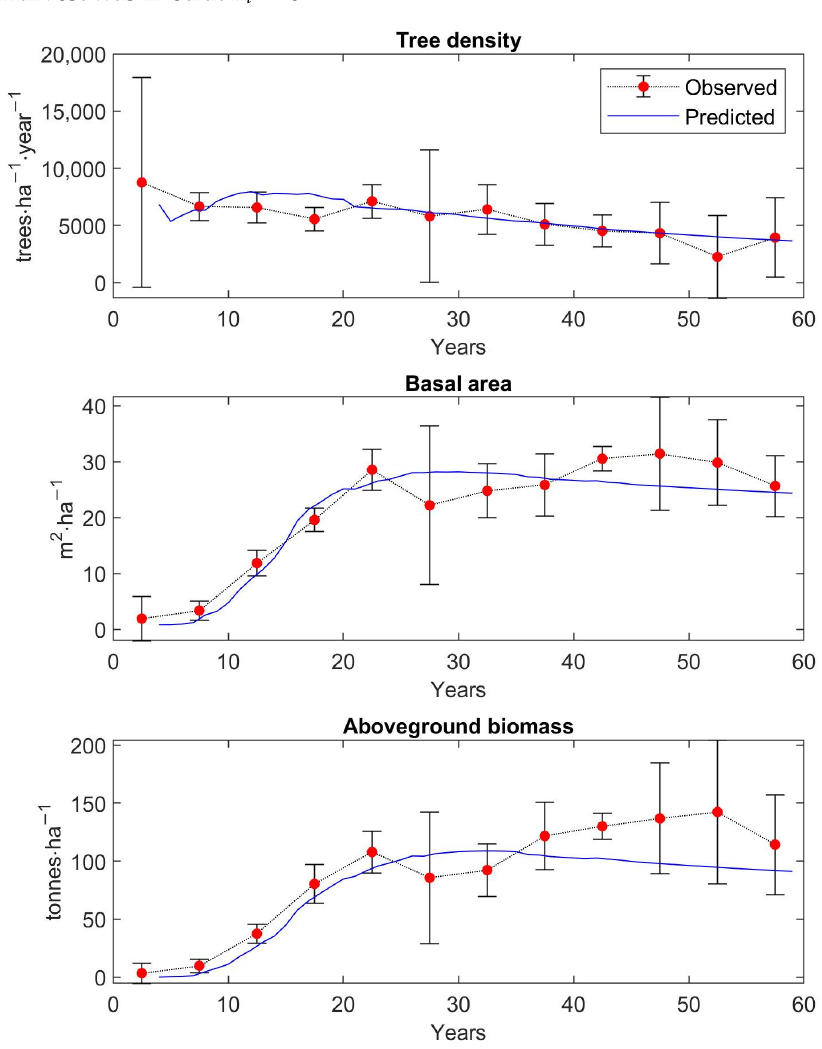
Figure 5. Verification of the model by the comparison of the observed 5-year average values with average predicted values of stem density, basal area, and AGB, with a 95% confidence interval, over 250 inventory plots.